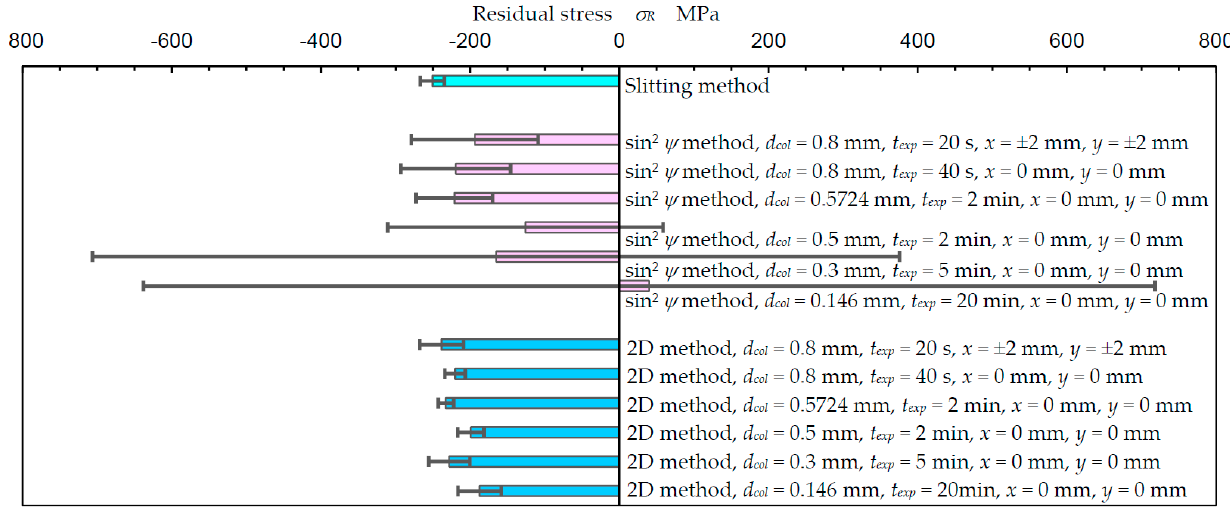
Figure 6. Comparison of the slitting method, sin 2 ψ method, and the 2D method for the residual stress of stainless steel treated by cavitation peening (specimen A).